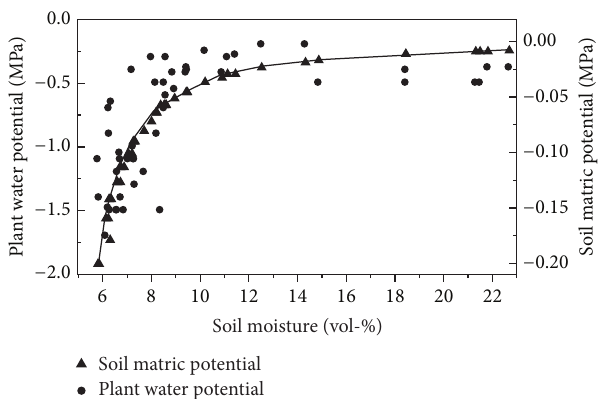
Figure 1: Predawn leaf water potential and soil matric potential in relation to the soil moisture and soil water retention curve.